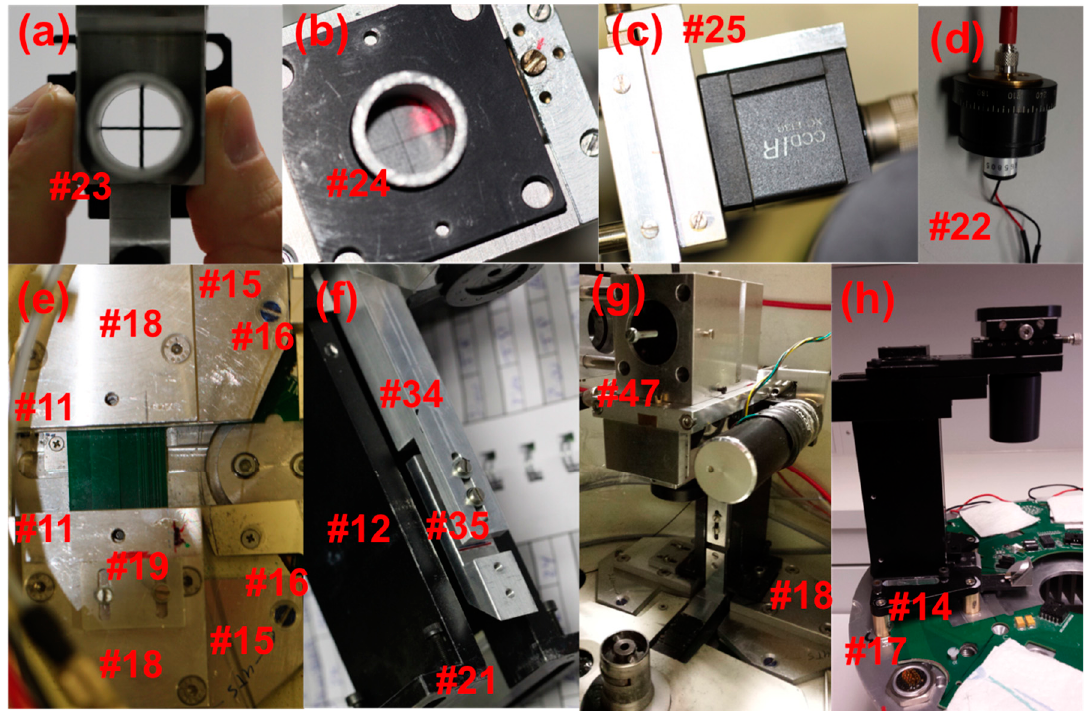
Figure 3. ( a ) Cross-bar device in lower imaging assembly. ( b ) Cross-hair screen mounted above lower imaging assembly; note beam is directed off-center in photo. ( c ) Sony XC-EI30 charge-coupled device (CCD) camera with custom adapter for attaching to the sliding rail assembly. ( d ) SMA fiber optic cable coupled laser diode. ( e ) XL-A type heat sink mounting base plates; holes for mounting to heat sink, additional mounting base plate, sliding guide block, extra arm mounting holes (below additional mounting base plate), cylinder stand offs (below base plate into heat sink). ( f ) Vertical connector: Arm slotted mounting holes with arm leveling screws. ( g ) Open-source MWL arm with mirror optics assembly. ( h ) Nanolytics MWL arm with lens optics assembly.